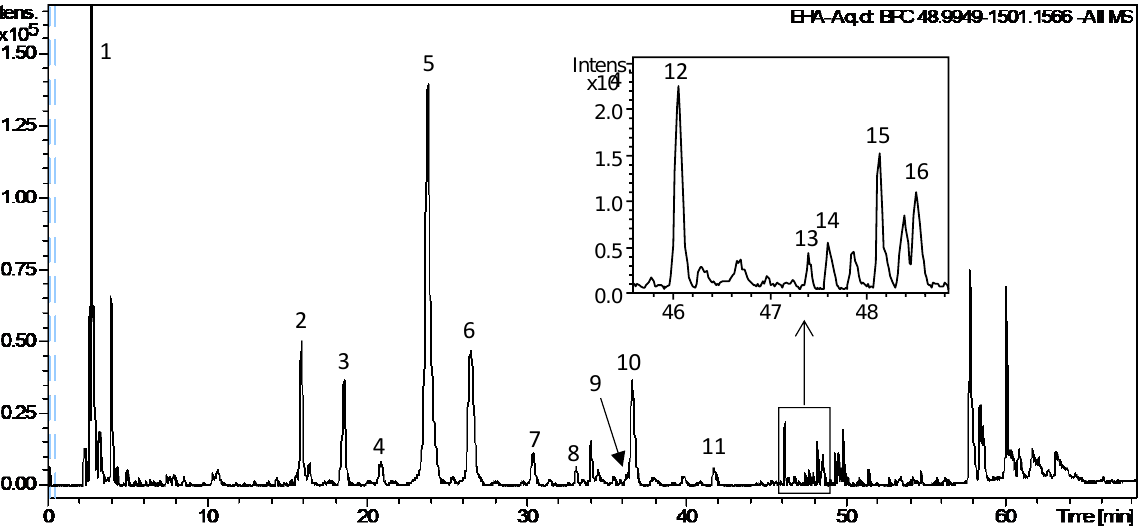
Figure 6. UPLC-MS chromatogram (BPC) of EHA-Aq fraction of Antiaris africana Engler leaves. The marked number is consistent with that of Table 1.